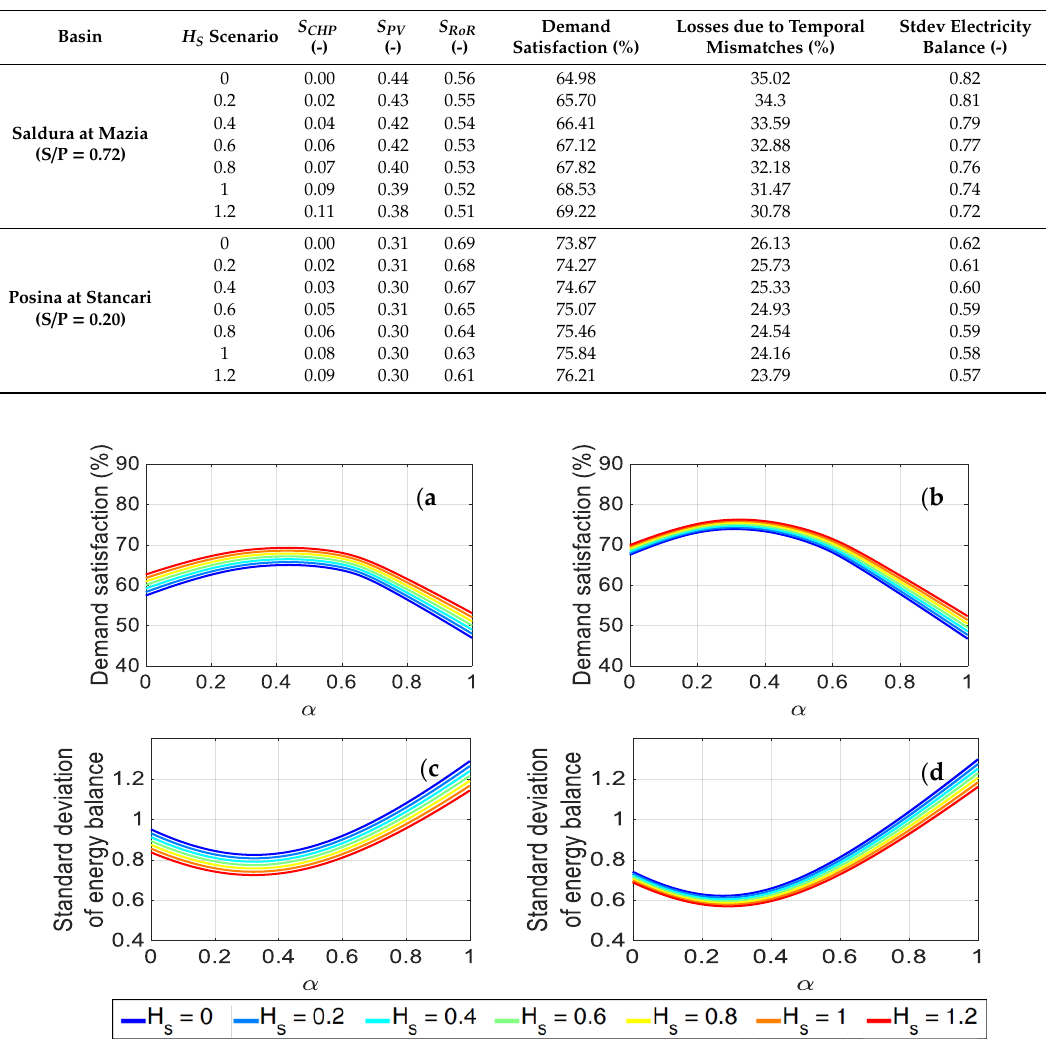
Figure 4. Demand satisfaction ( a , b ) and standard deviation of the electricity balance ( c , d ) as function of the share of solar PV generation ( α ) that covers the residual load (1 − S CHP ) E D . Note that the share of RoR hydropower generation is ( 1 − α ) . Results for Saldura at Mazia and for Posina at Stancari are reported in the left and right columns respectively. The various curves in color show changes in demand satisfaction and electricity balance variability as a function of the penetration level of CHP heat generation.